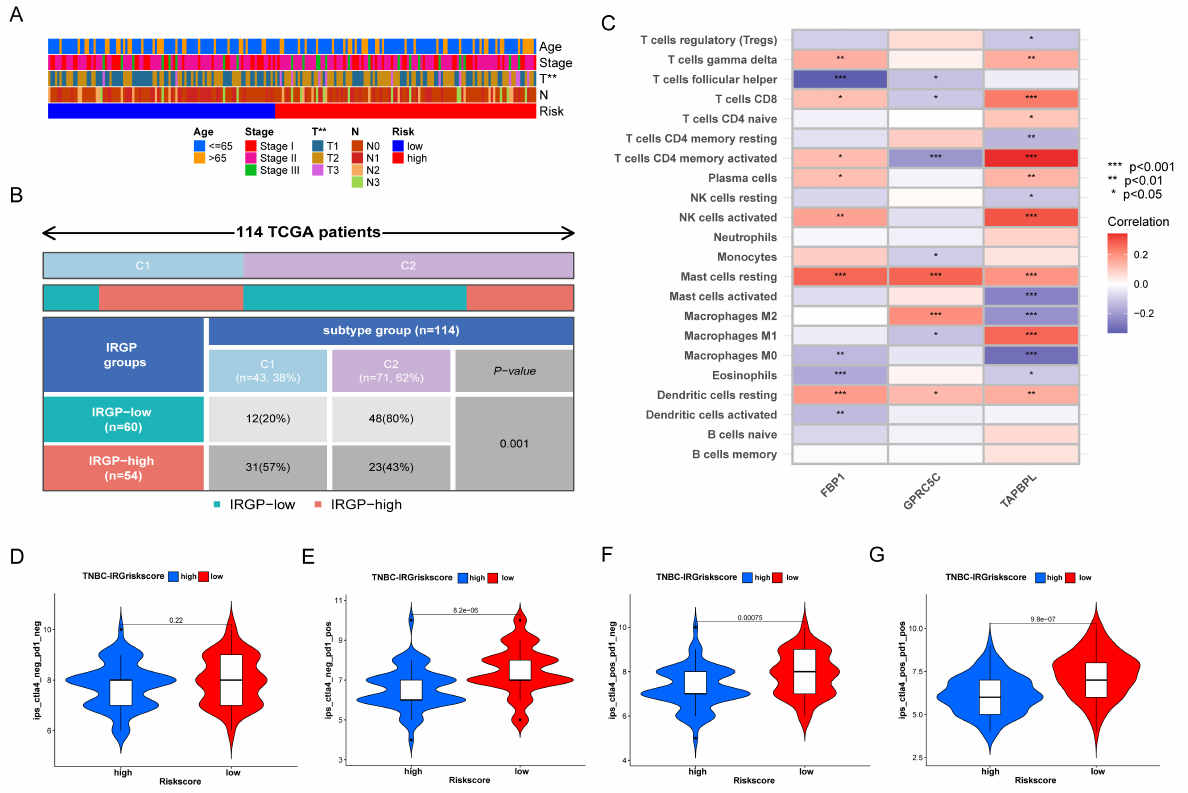
Figure 9. Predictive value of IRGP model in immune subtypes and IPS. ( A ) Heatmap showing the relationship between IRGP model and clinicopathological parameter, ** p < 0.01. ( B ) Heatmap showing the relationship between IRGP model and immune subtypes. ( C ) Heatmap showing the correlation of FBP1, GPRC5C and TAPBPLwith the infiltrating of 22 immune cells. ( D – G ) The relative distribution of IPS identified by the status of CTLA-4 or PD-1 was compared between high IRGriskscore versus low IRGriskscore in TCGA-TNBC